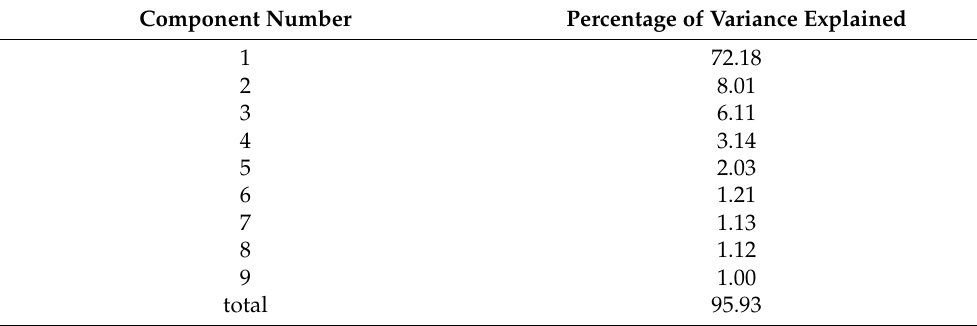
Table 2. Percentage of variance of the selected components of PCA on 500-hPa geopotential height. Component